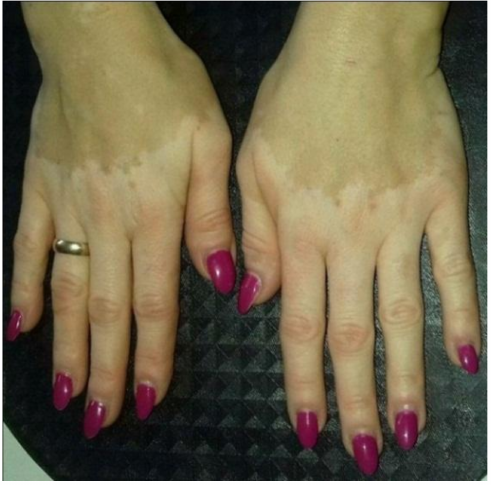
Figure 2. Hands of the patient with